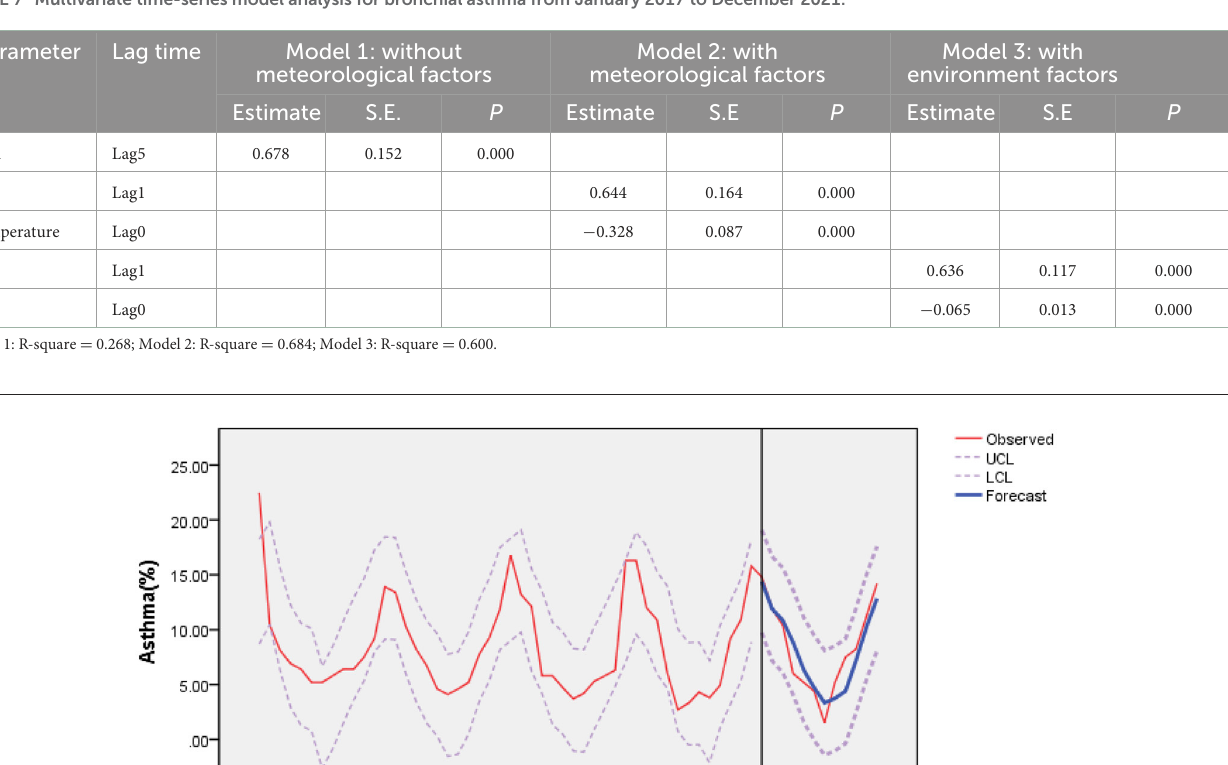
TABLE 7 Multivariate time-series model analysis for bronchial asthma from January 2017 to December